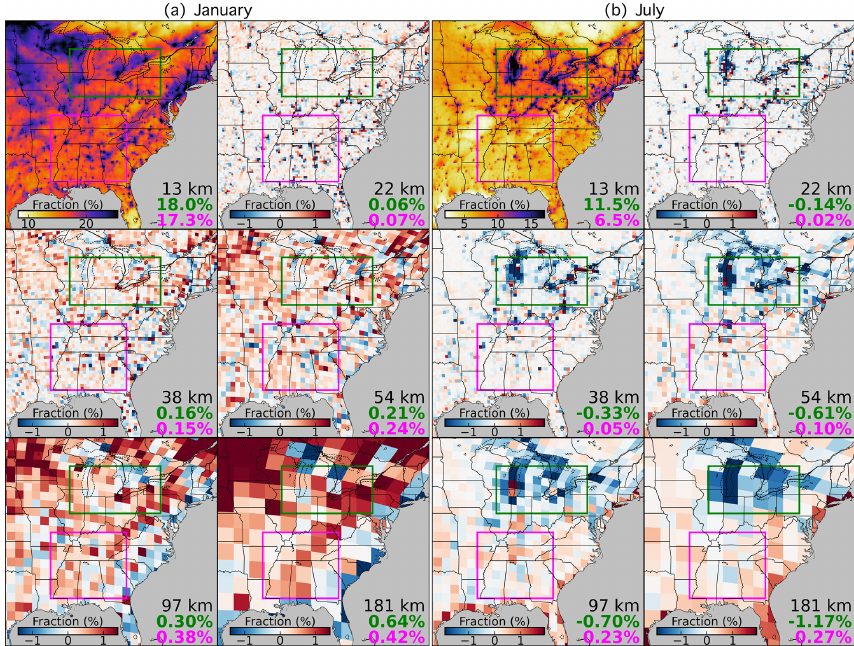
Figure 6. Coarse-resolution simulations yield variable biases in satellite-based estimations of surface NO 2 concentration. Panels (a) and (b) are both similar to Fig. 1c (for January and July 2015, respectively) but for the fraction (%) of NO 2 tropospheric column within the surface layer during afternoon satellite overpass time (19:00–21:00UTC). The numbers for the other resolutions vs. 13km resolution are absolute differences in percentage number.